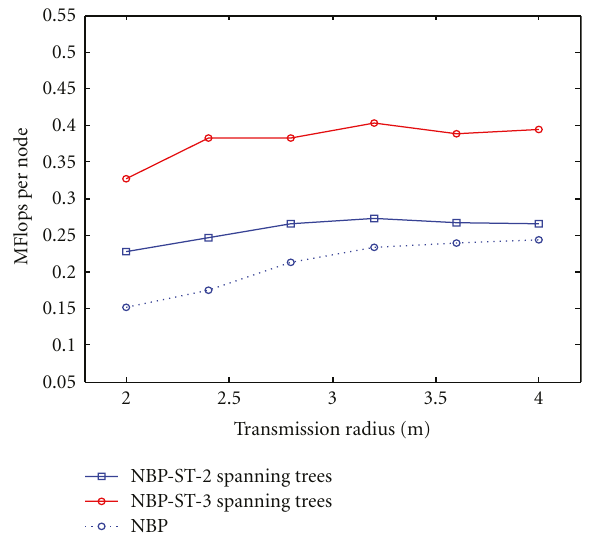
Figure 13: Comparison of computational cost.